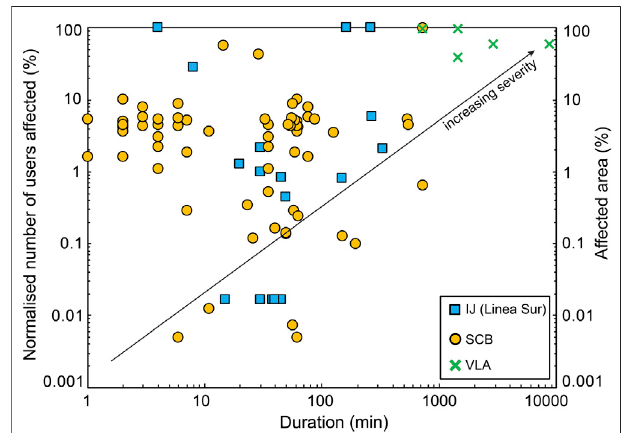
FIGURE 7 | Severity of power outage impacts in terms of duration vs. normalizednumberofusers(forSCBandIJ)oraffectedarea(forVLA).Source of data: IJ (Company of Electricity of Río Negro – EDERSA data log), SCB (Cooperative of Electricity of Bariloche data log), VLA (Civil Protection